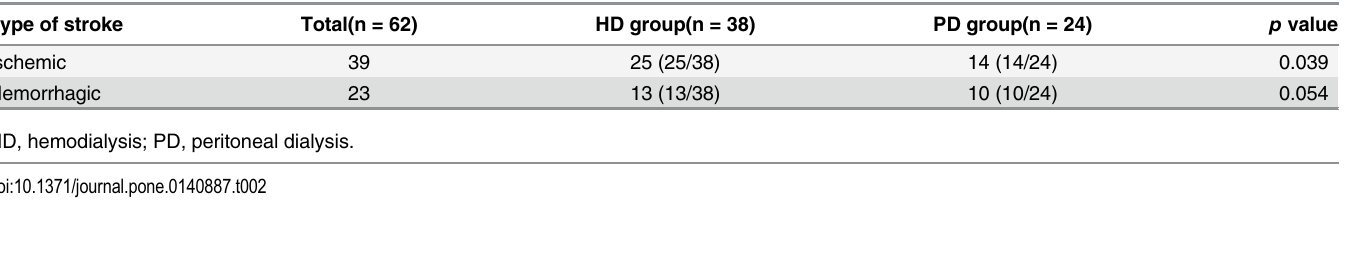
Table 2. Case rates by type of stroke in the study